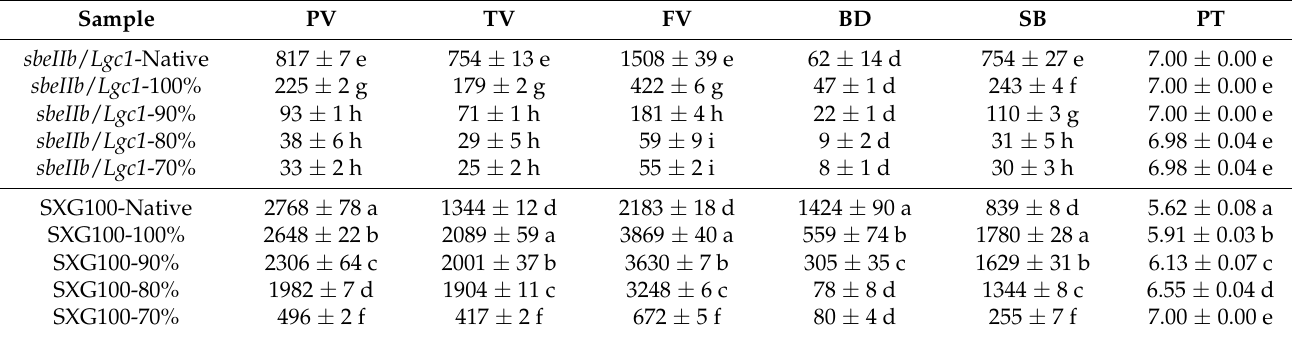
Table 4. Pasting properties of native and HMT rice flours of sbeIIb / Lgc1 and